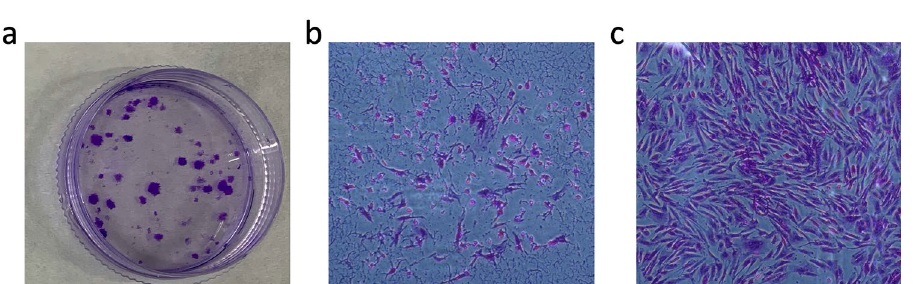
Figure 4. Clonogenicity of magnetic bead sorted SUSD2 + cells seeded at a plating density of 200cells/cm 2 . ( a ) Two types of colonies formed after 4 weeks: small colonies of approximately 50 cells loosely packed cells ( b ), and large colonies of more than 200 tightly packed cells ( c ).